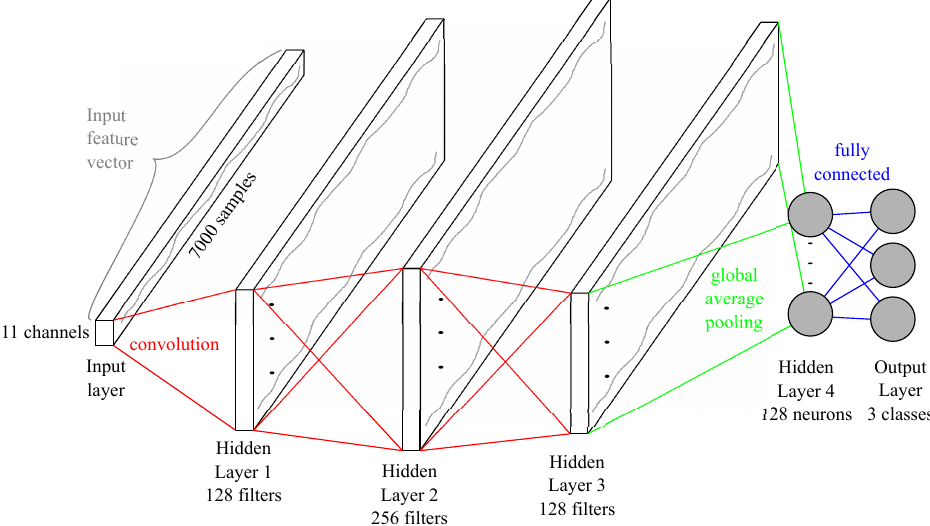
Figure 7. Schematic visualization of the FCN architecture for the three classes